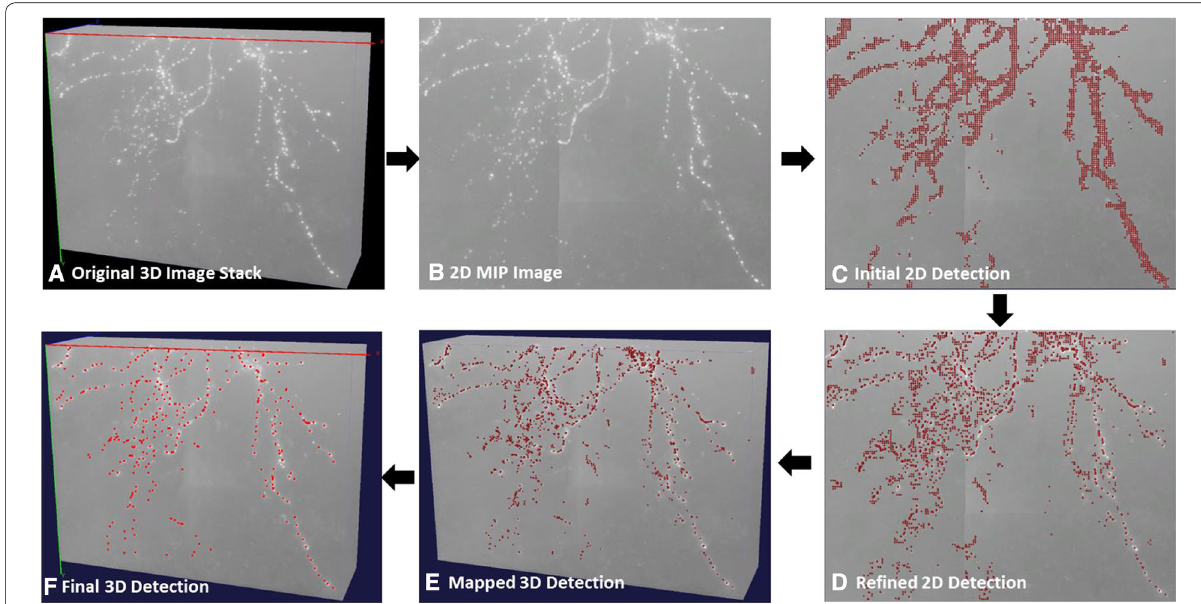
Fig. 2 The workflow of 3D neurite signal detection. ( a ) An example of the original 3D image stack. It is a cropped 3D bright‑field image of a biocytin‑labeled mouse neuron; the pixel resolution is 0.14 um 0.14 um 0.28 um. ( b ) 2D MIP on the XY plane. ( c ) Initial neurite signal detected × × by a deep CNN model (AlexNet in this case). ( d ) Refined 2D signal detection result using a mean shift. ( c ) and ( d ) are overlaid on top of B. ( e ) Mapped 3D detection result based on local maximum intensity along Z‑direction. ( f ) Final 3D detection result after deep learning‑based refinement. ( e ) and ( f ) are overlaid on top of ( a ). Red dots indicate 2D/3D detected signals